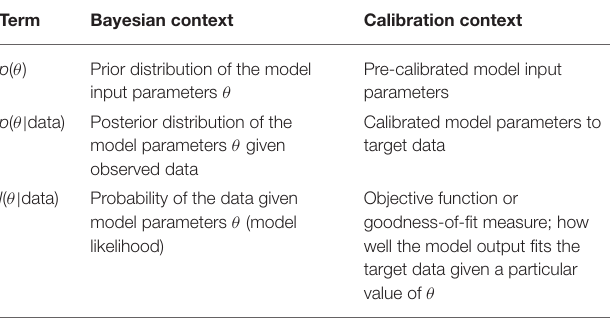
TABLE 1 | The Bayes formula in a calibration